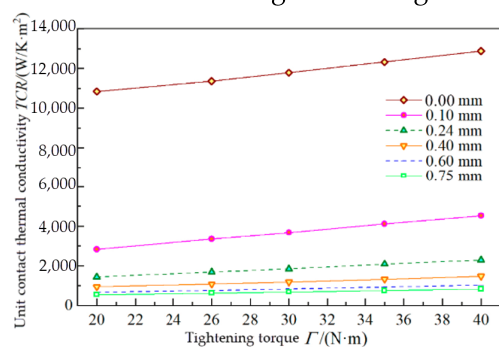
Figure 13. Effect of tightening torques with contact thermal resistance and thermal conductivity at different flange clearances for the Q345R–Q345R material.